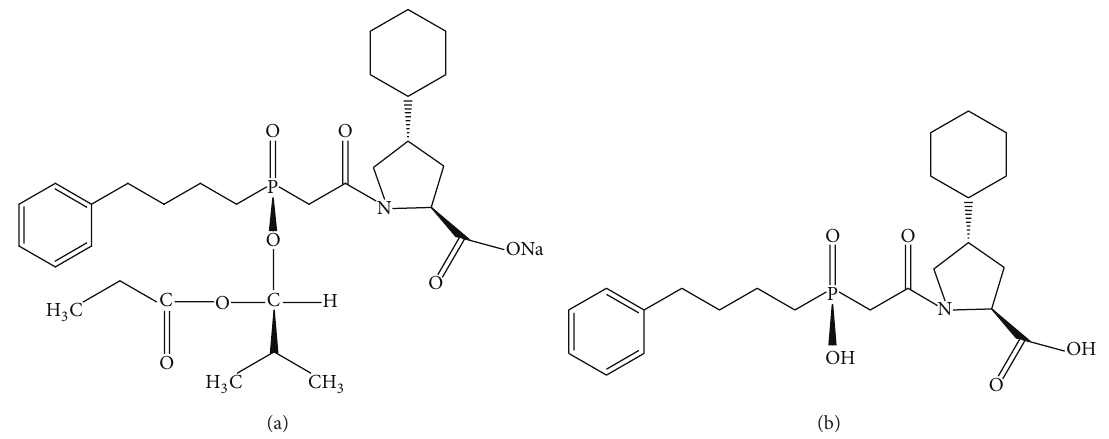
Figure 1: Chemical structure of (a) fosinopril sodium and (b) fosinoprilat.